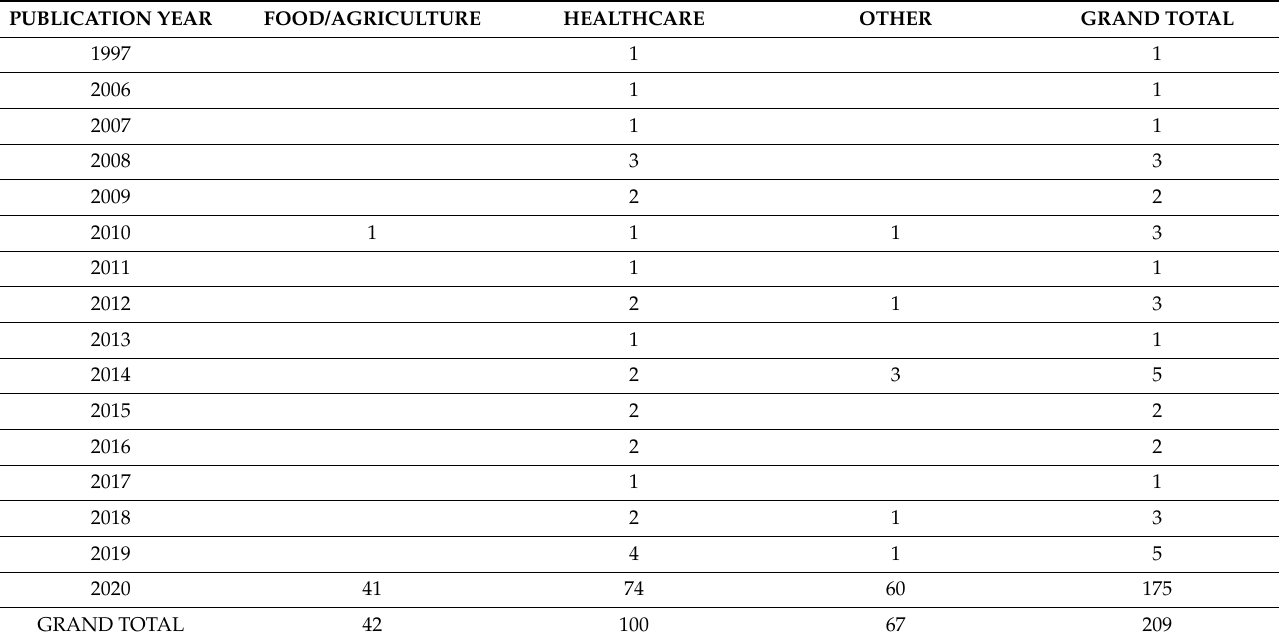
Table 6. Research Articles by Supply Chain